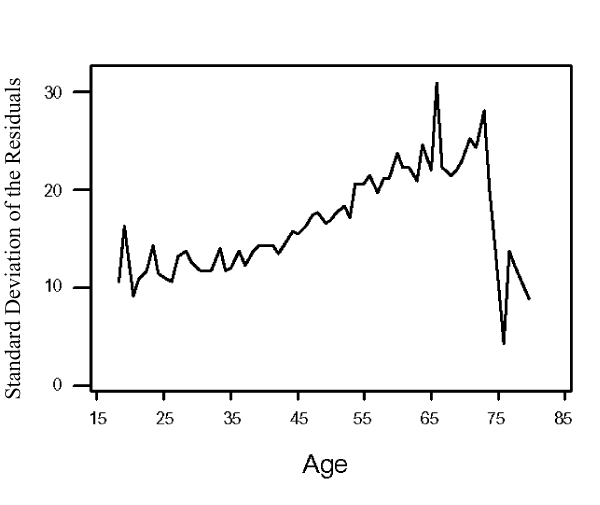
Residual variability according to age